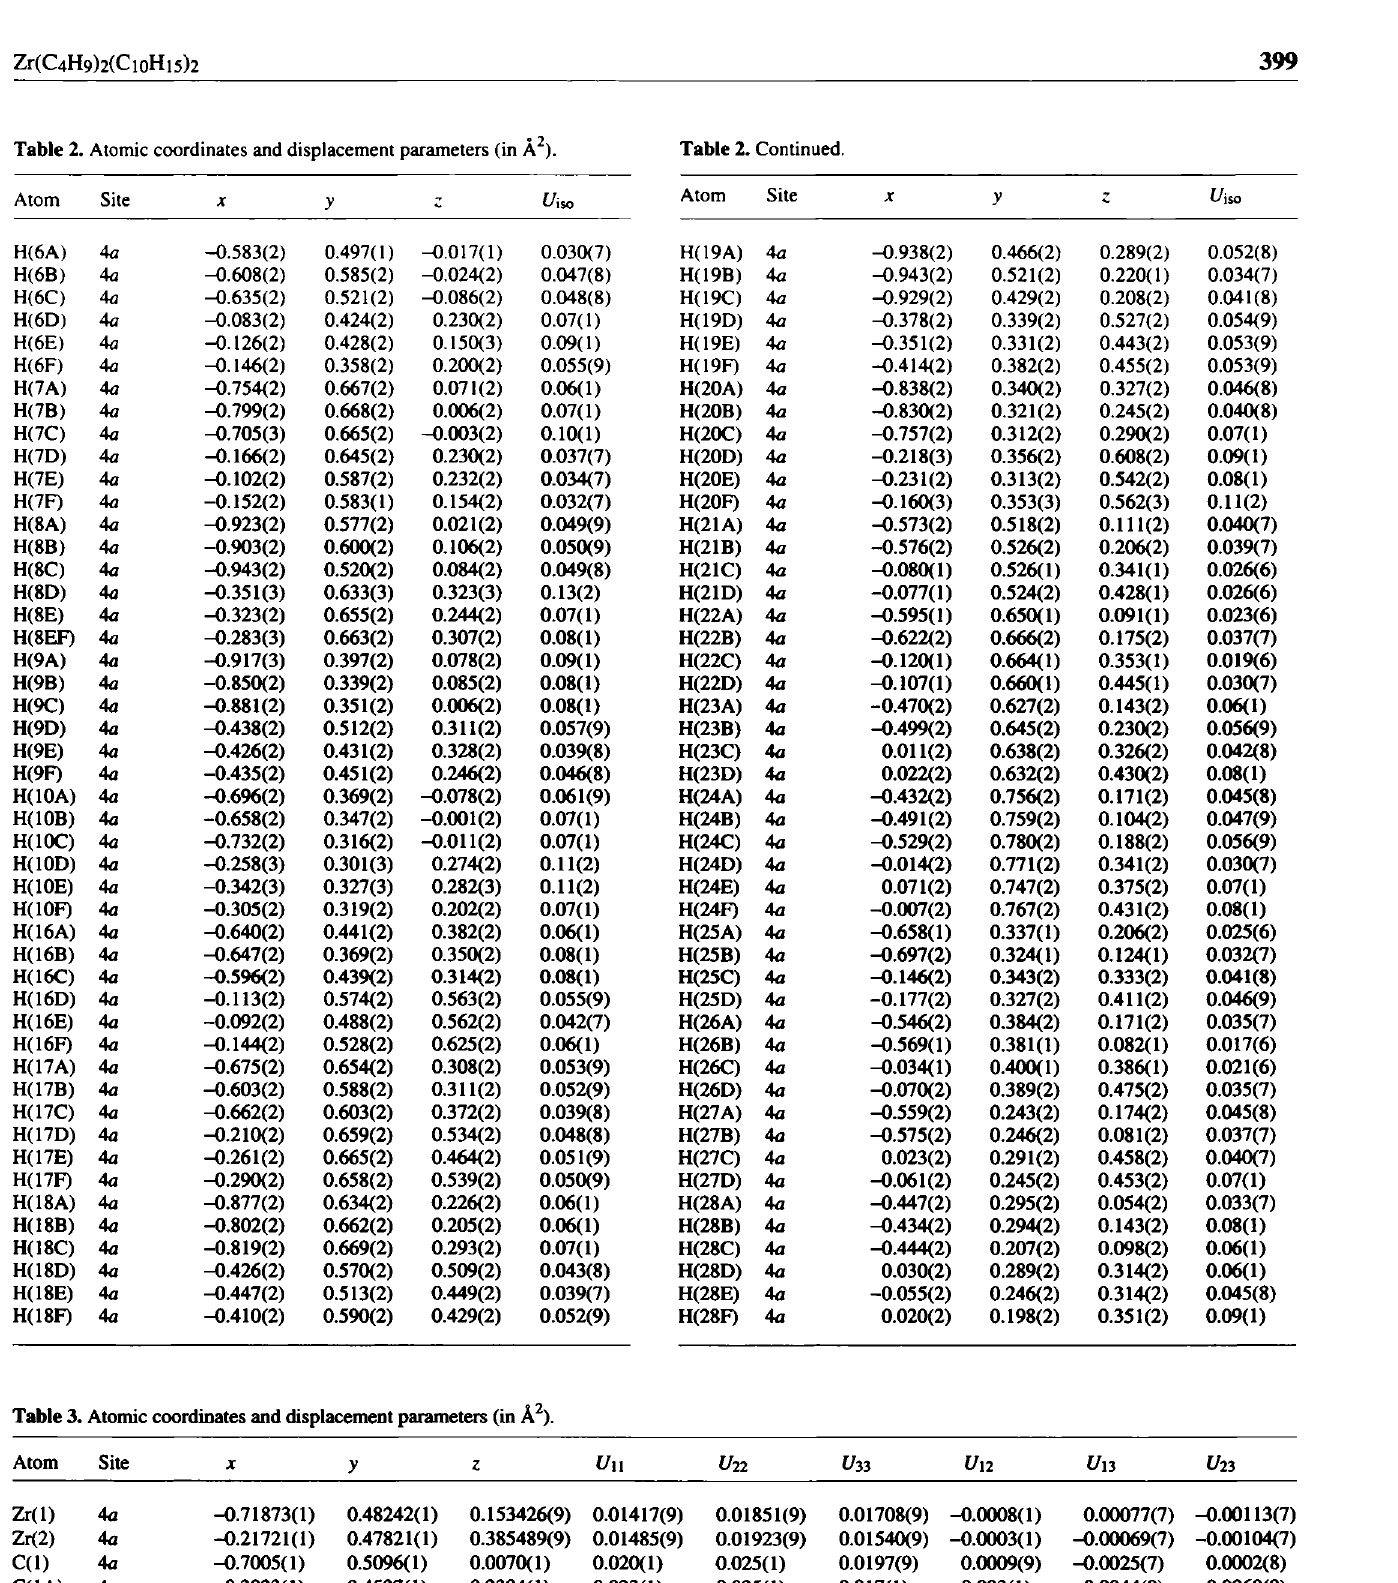
Table 3. Atomic coordinates and displacement parameters (in Ä 2